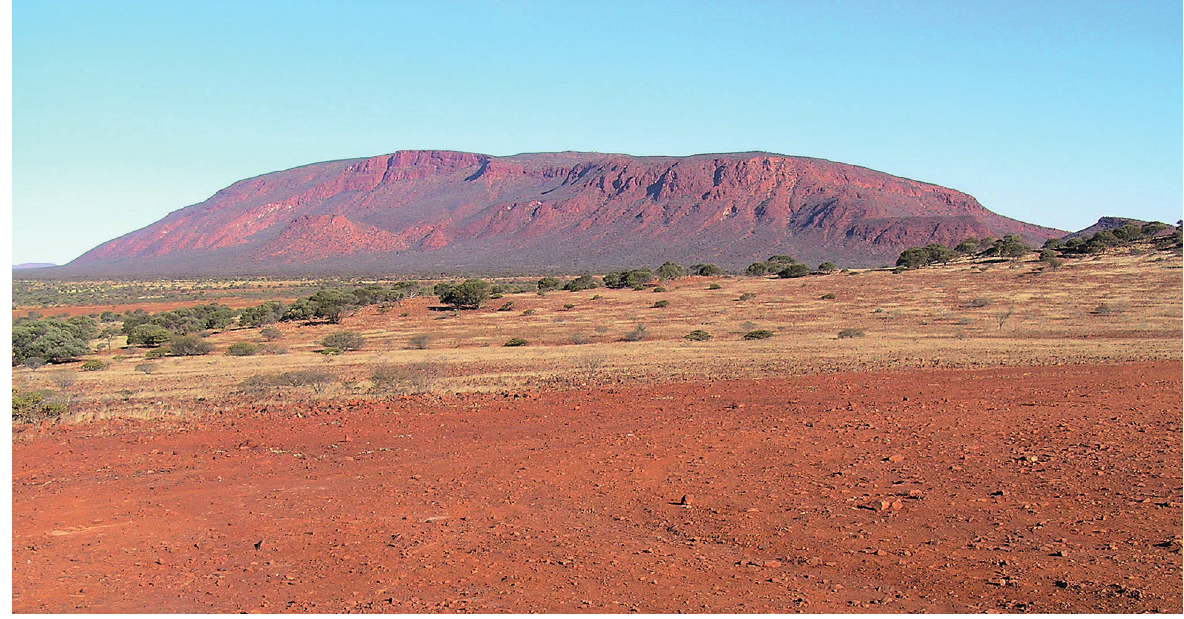
Fig. 2. Mount Augustus, Western Australia (Photo R.P. Bourman).